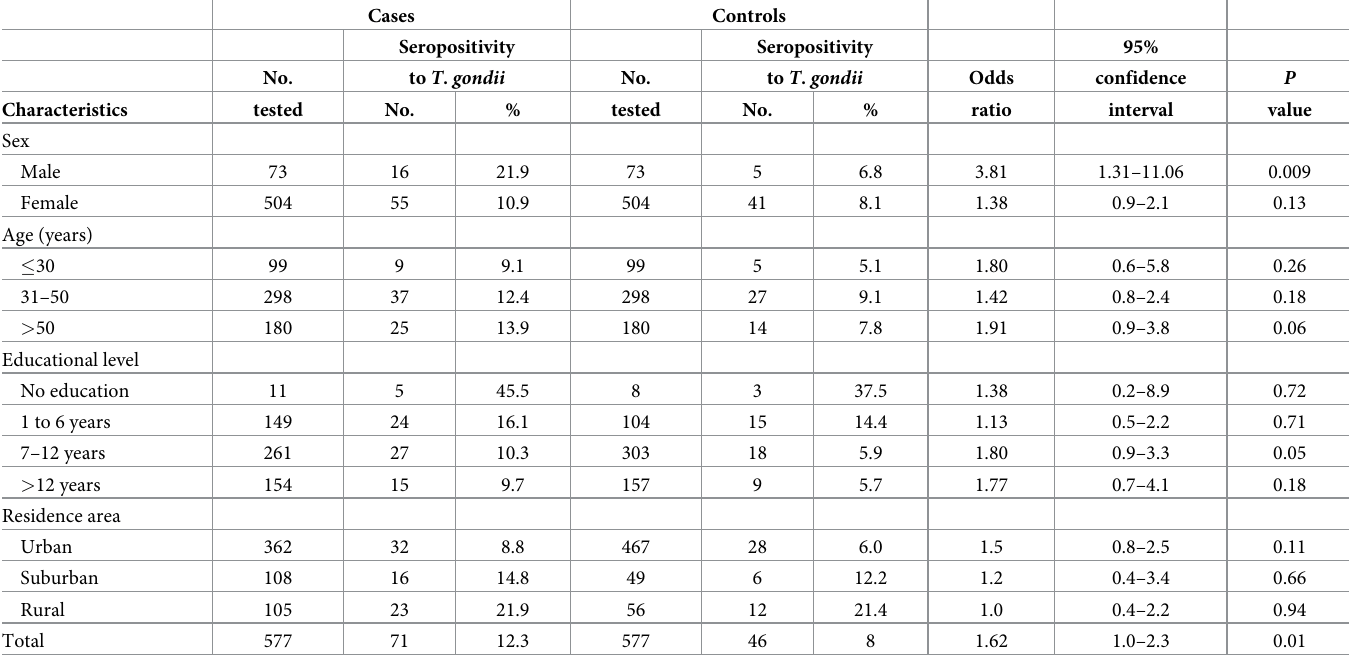
Table 1. Stratification by sociodemographic variables in cases and controls and IgG seropositivity rates to T . gondii .